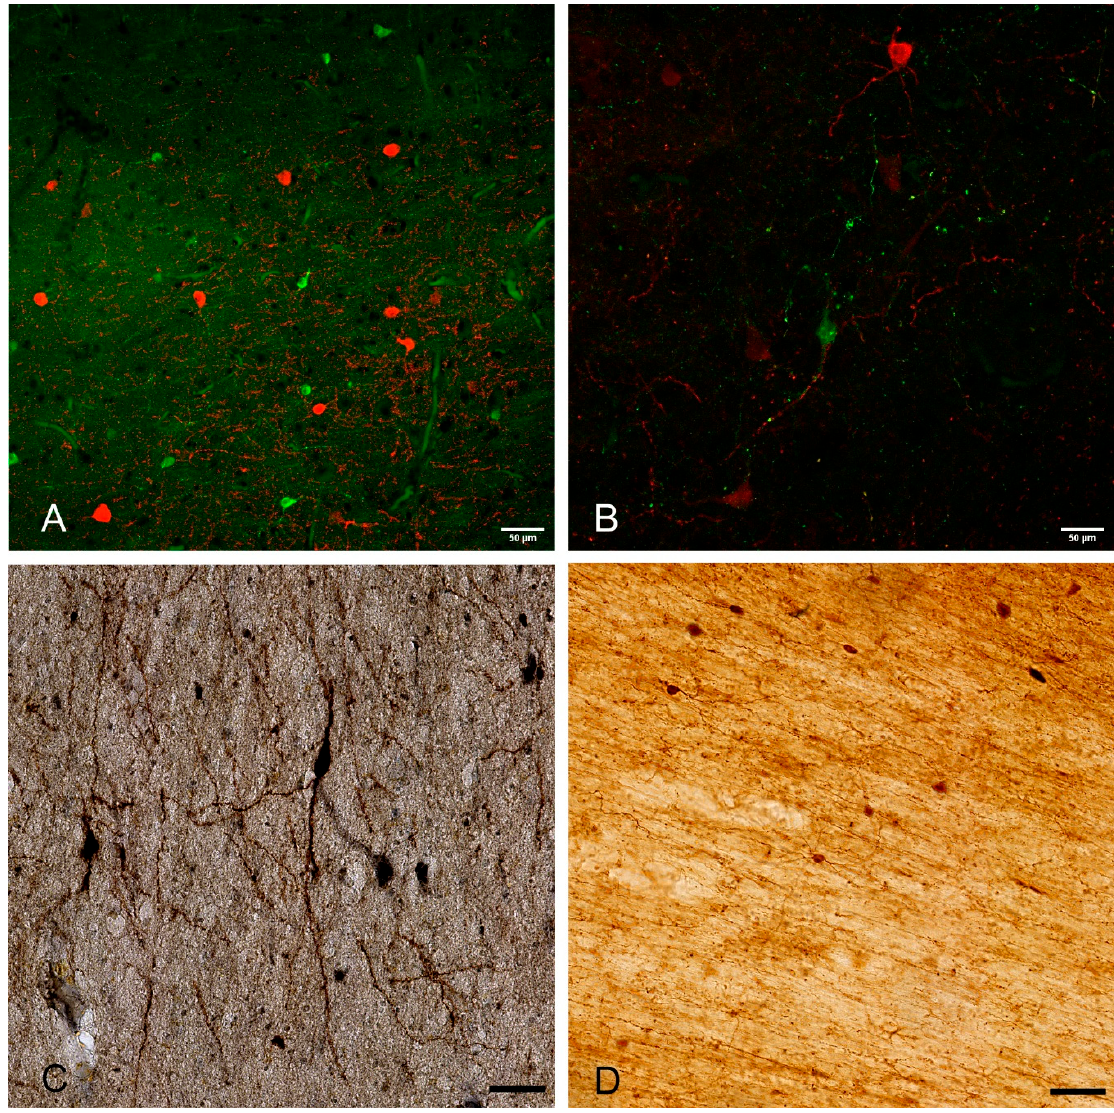
Figure 2. Examples of WMIN in the human brain ( A – C ) and rhesus monkey brain ( D ). The depicted WMIN are positive for calretinin (green in ( A ) and ( B ), ( D )), parvalbumin (red in ( A )), calbindin (red in ( B )), and nNOS ( C )). Note that all neurons in both human and rhesus monkey show extensive dendritic arborization. Bar = 50 µm. We would like to thank Professor Zdravko Petanjek and Professor Monique Esclapez for the images.